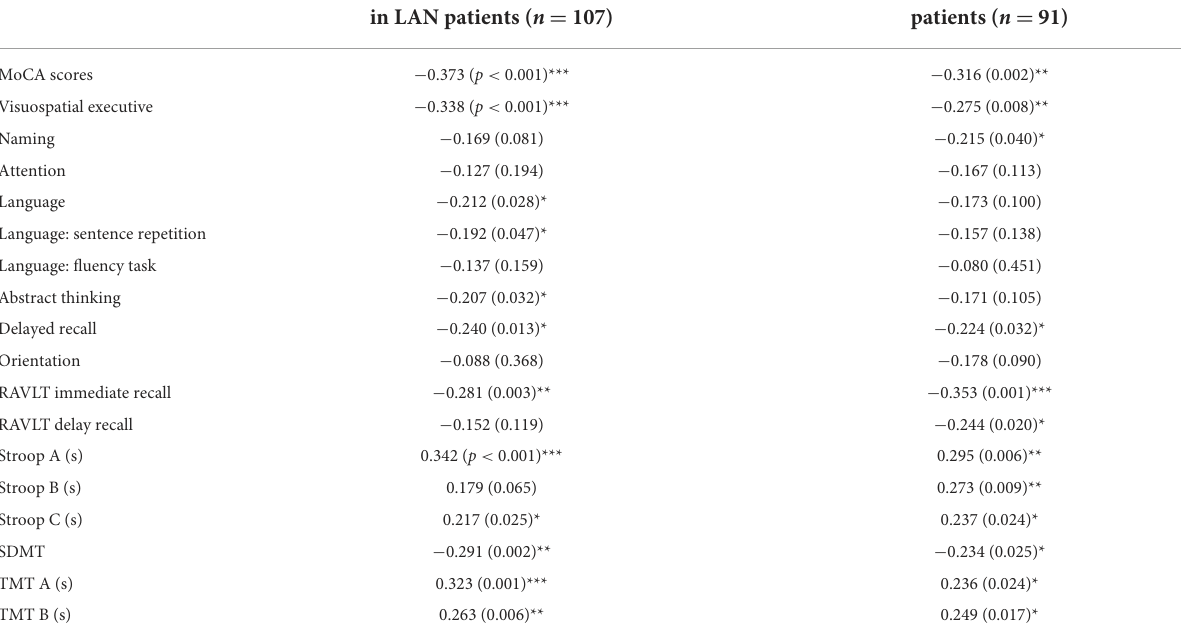
TABLE 3 Correlation analysis between mALFF and cognitive scale in patients with acoustic neuroma. mALFF of the right caudate nucleus in LAN patients ( n = 107)